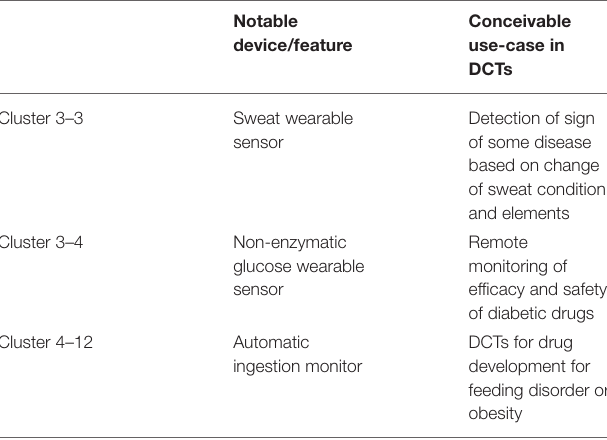
TABLE 6 | Notable device/features and conceivable use-case in